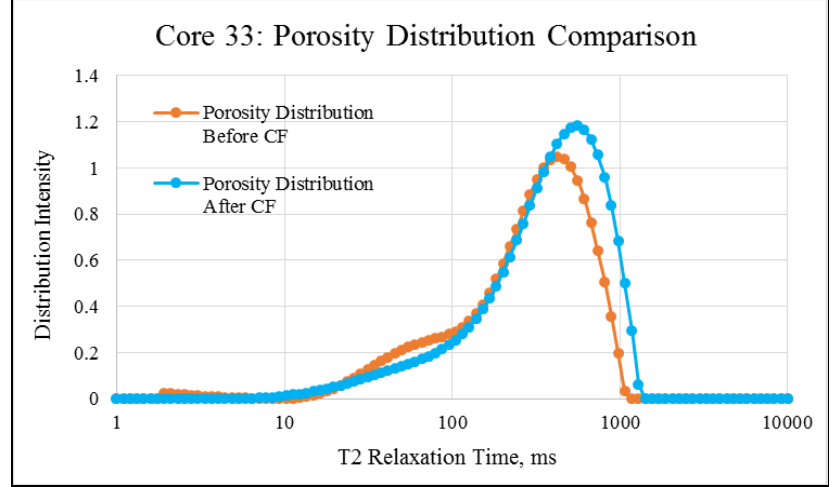
Figure 8. NMR porosity distribution comparison of C#33: before and after the coreflood.